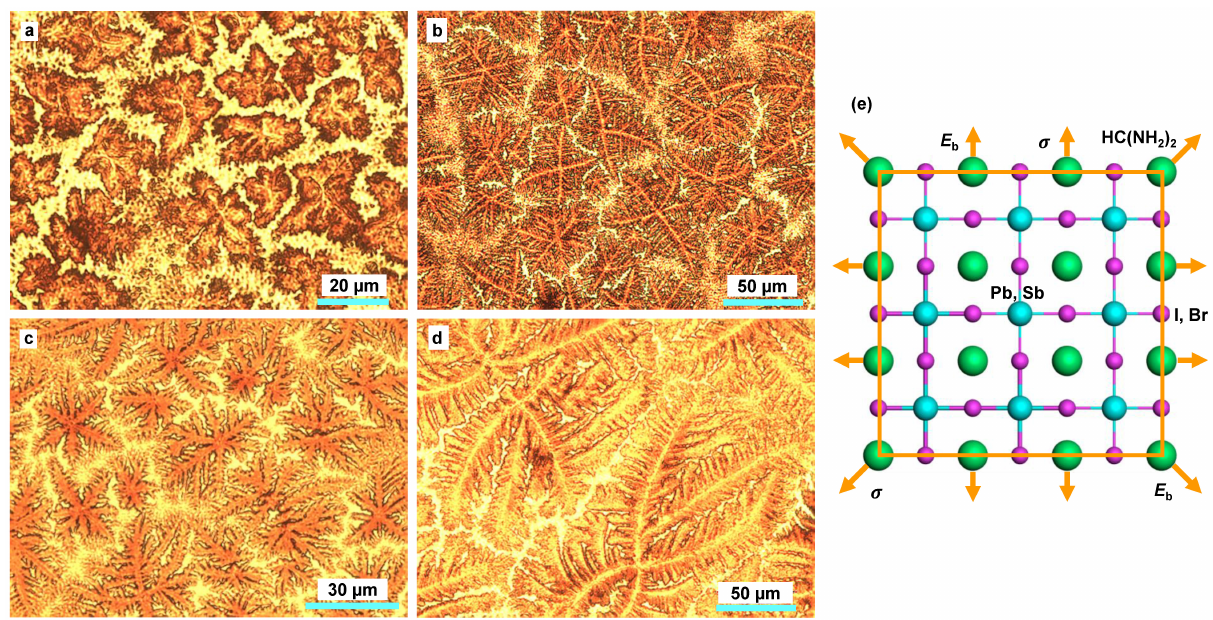
Figure 42: Optical microscope images of (a) HC(NH 2 ) 2 PbI 3 , (b) HC(NH 2 ) 2 PbI 2.85 Br 0.15 , (c) HC(NH 2 ) 2 PbIBr 2 , and (d) HC(NH 2 ) 2 Pb 0.95 Sb 0.05 I 3 . (e) Grain growth of the perovskite.